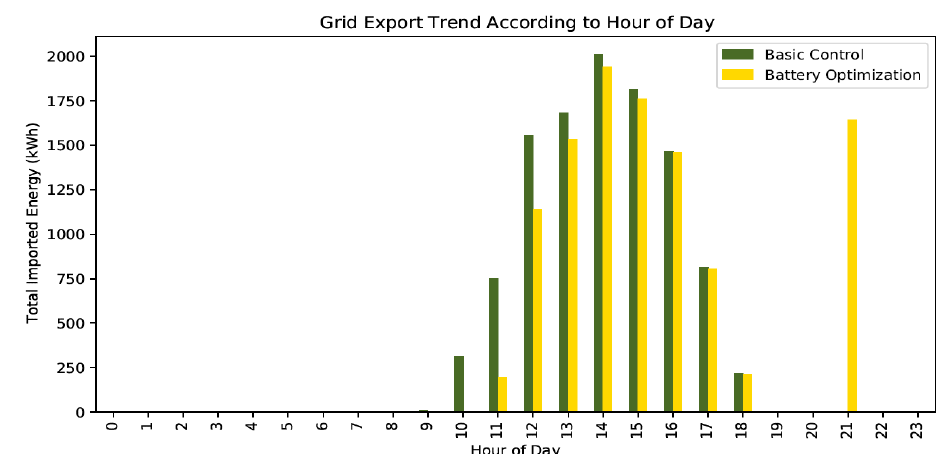
Figure 13. Grid export distribution between methodologies.